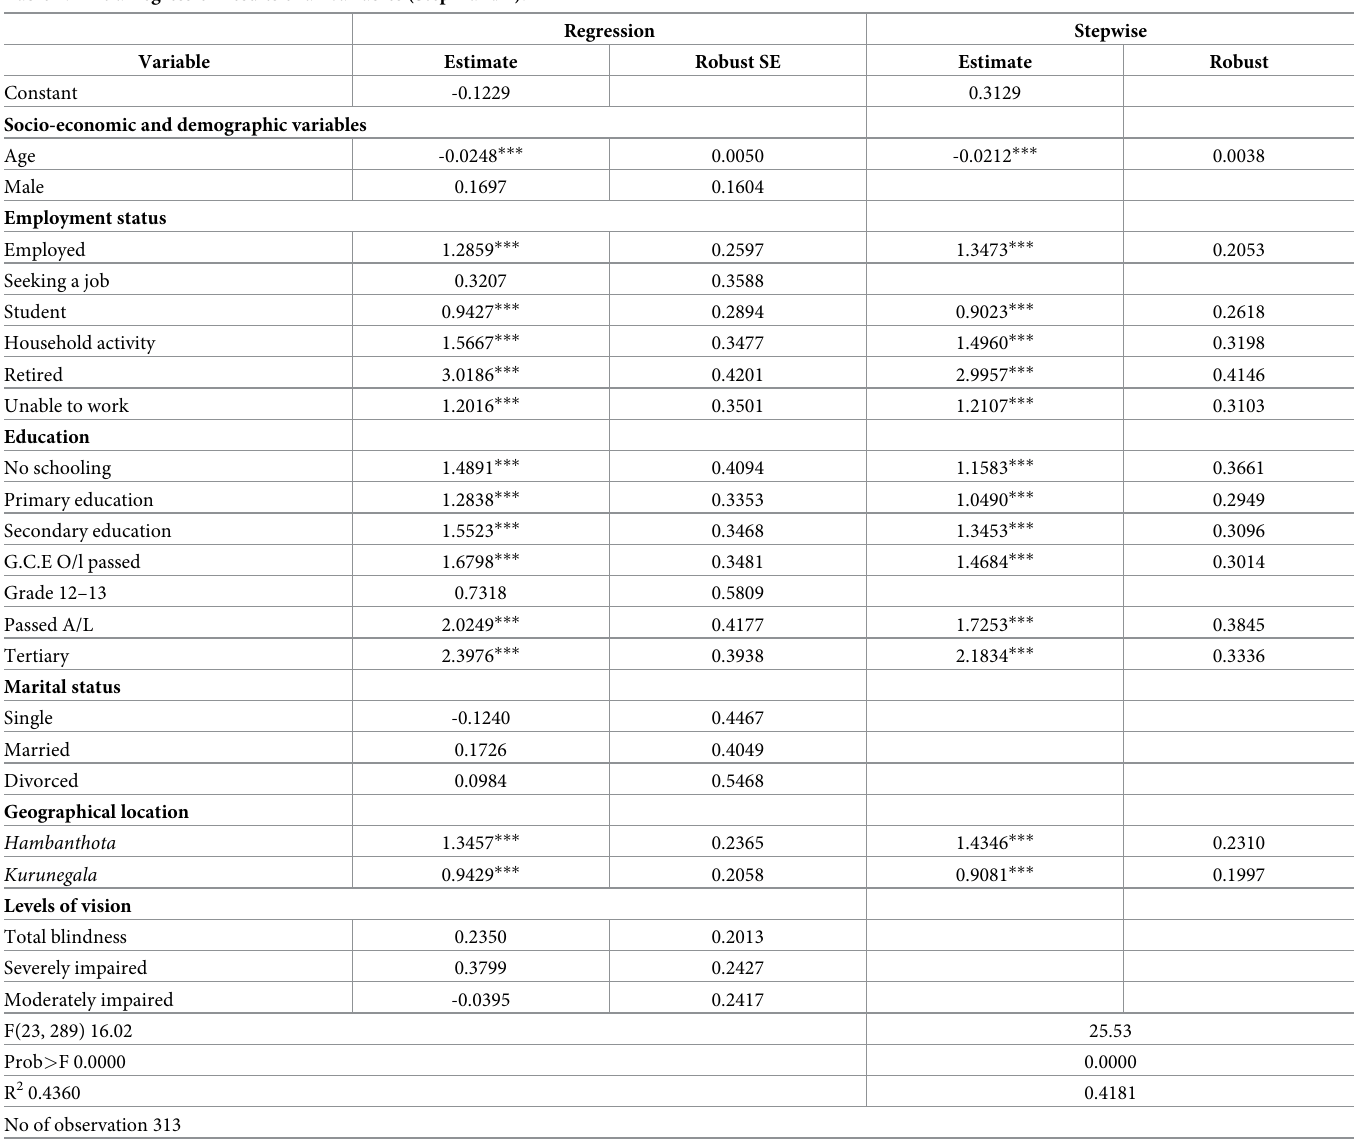
Table 4. Initial regression results of all variables (Step 1 and